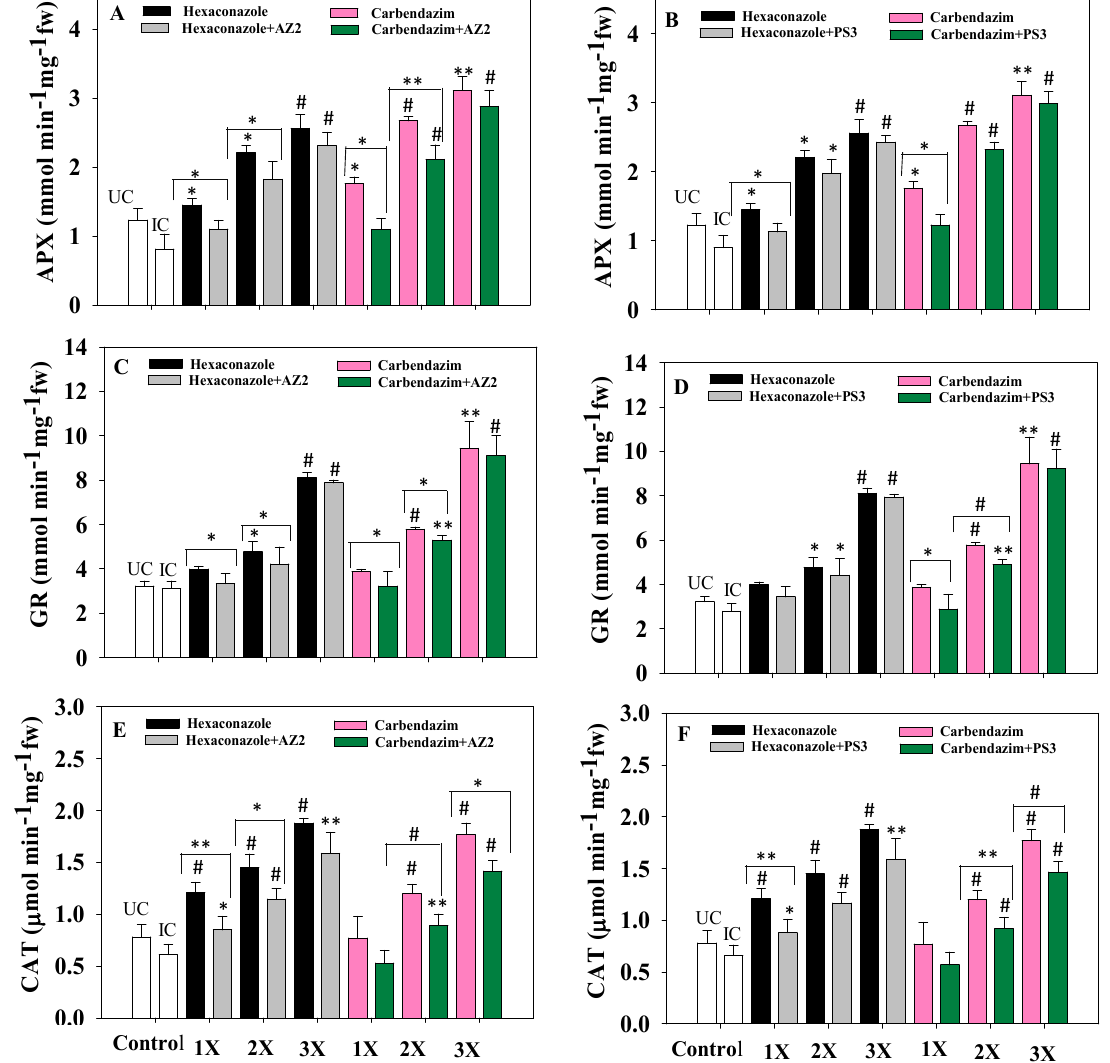
Figure 10. Effects of inoculation of fungicide-tolerant Pseudomonas sp. AZ2 on ascorbate peroxidase (APX) ( A ), glutathione reductase (GR) ( C ) and catalase (CAT) ( E ) activities in fresh foliage (fw) of radish plants grown in soil treated with carbendazim and hexaconazole. Panels ( B , D , F ) depict the impact of Pseudomonas sp. PS3 on APX, GR and CAT activities, respectively, in the presence of fungicides. Each value is a mean of three replicates ( n = 3). Histograms represent the mean value of three independent replicates ( n = 3) and error bars represent S.D. The asterisks *, ** and # denote statistical significance at p < 0.05, p < 0.005 and p < 0.001, respectively computed by Student’s t -test. UC = Uninoculated control, IC = Inoculated control. 1X, 2X and 3X denote the normal, two times and three times greater concentrations of fungicide.